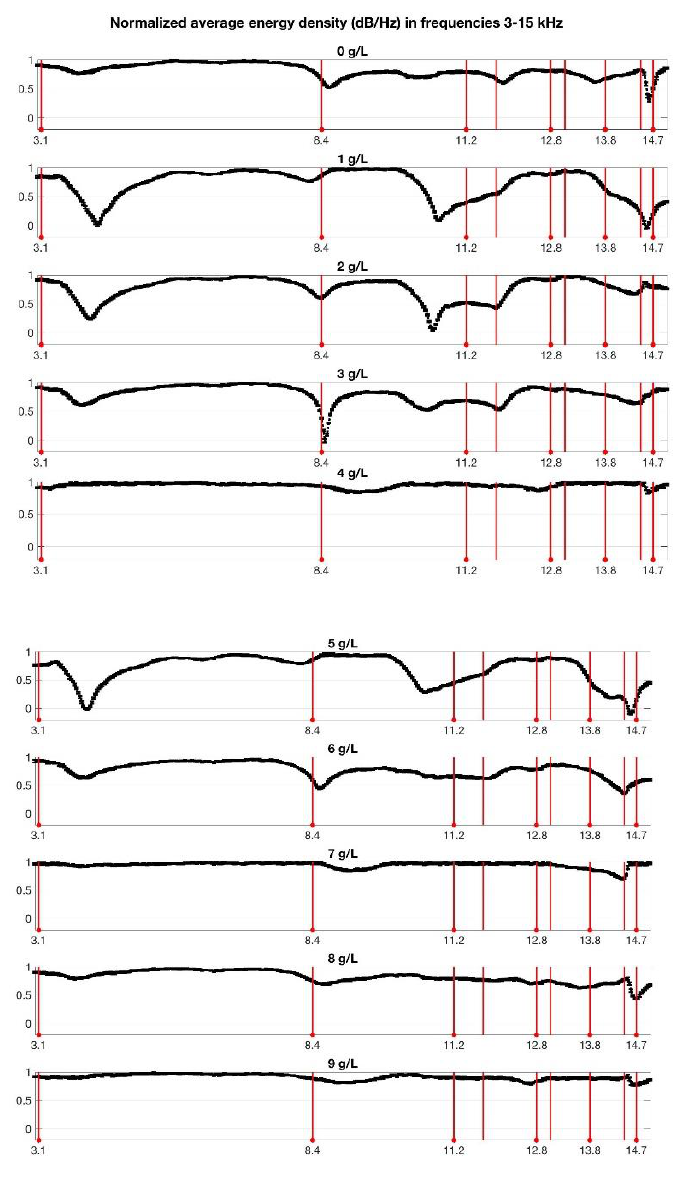
Figure 5. Spectral information of vibrational absorption bands of 10 concentrations from 0 g/L to 9 g/L. The curves represent the average and normalized values of the sound pressure level (dB/Hz) over the audible frequencies range. In each spectrum, the frequencies used for both classifiers are emphasized.